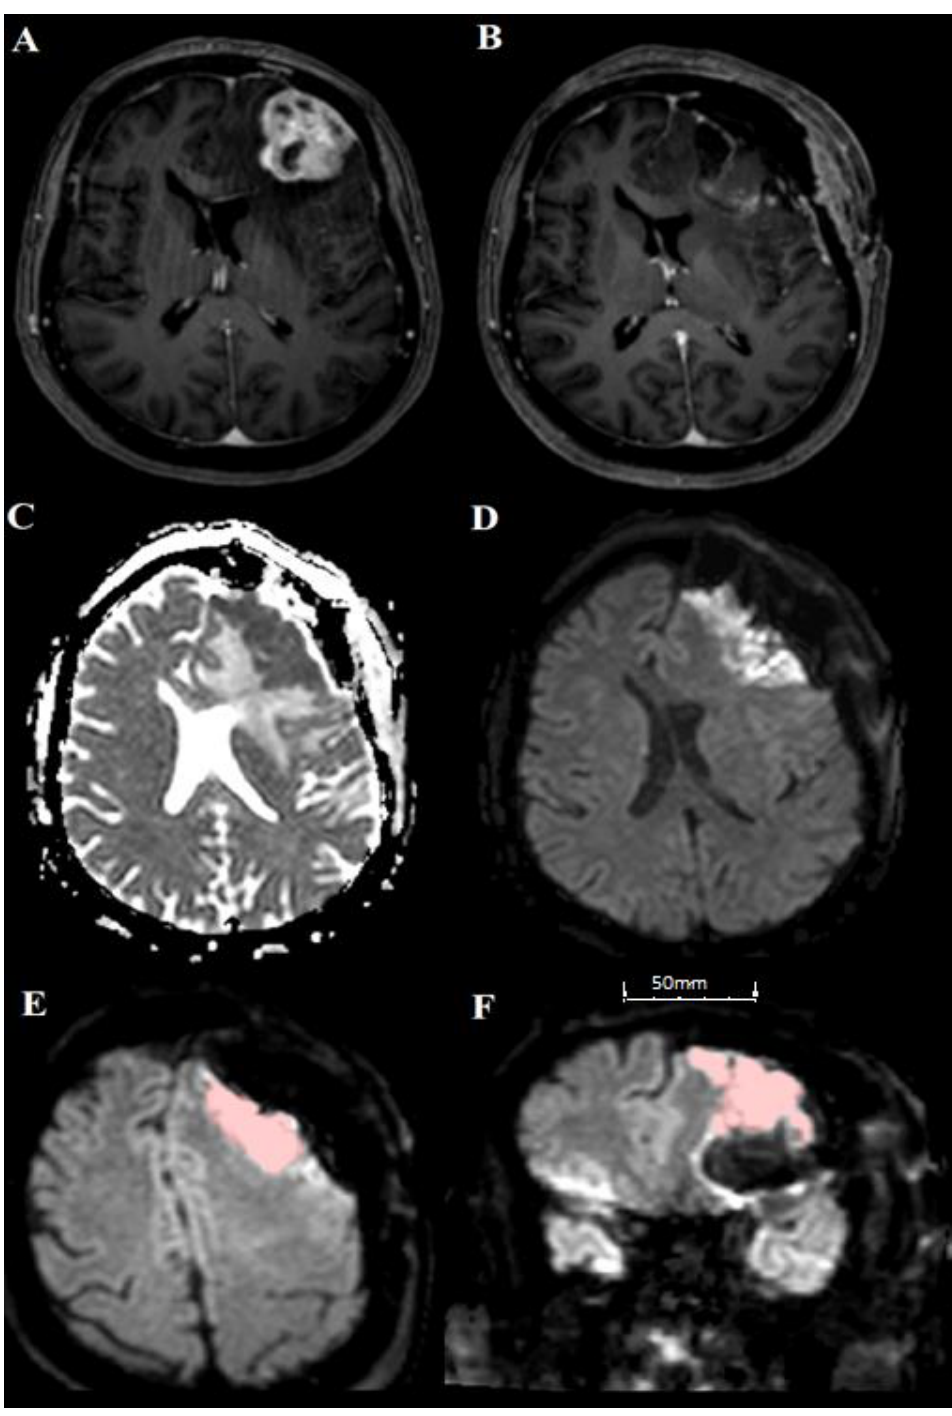
Figure 1. Example of one patient (70-year-old female with breast cancer) with left frontal metastasis. ( A , B ) show T1 contrast-enhanced images to compare preoperative (left) and postoperative (right). ( C , D ) show left frontal infarction with hyperintensity in b-1000 images ( D ) and corresponding hypointensity in ADC ( C ). ( E , F ) show an example of semiautomatic volumetric measurement of the postoperative infarct region, axial ( E ) and coronar ( F